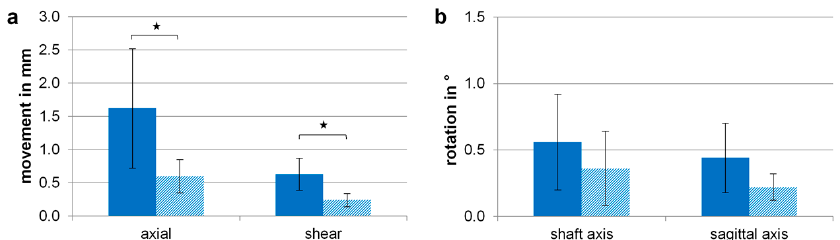
Figure 3. Resulting motion for the reduced fracture condition at maximum applied load of 2000 N and 4 Nm after dynamic loading of the NailOnly (solid bar) and the Nail + Cable (dashed bar) groups for ( a ) axial and shear movements and ( b ) rotational movements around the shaft axis and the sagittal axis. Values are given as mean ± standard deviation and significant differences are marked by the asterisk symbol (* p < 0.05).